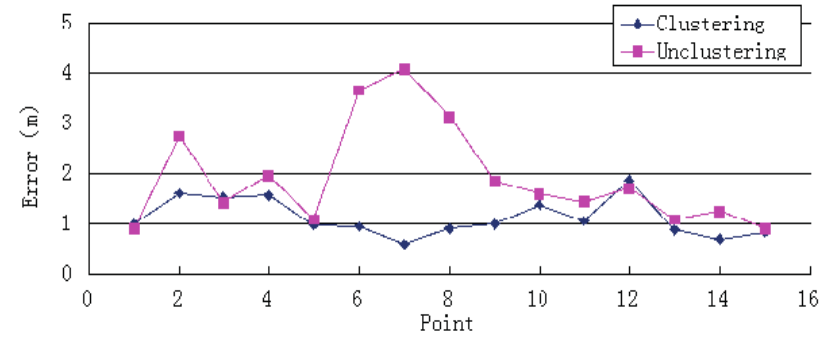
Figure 5. Single-point positioning average